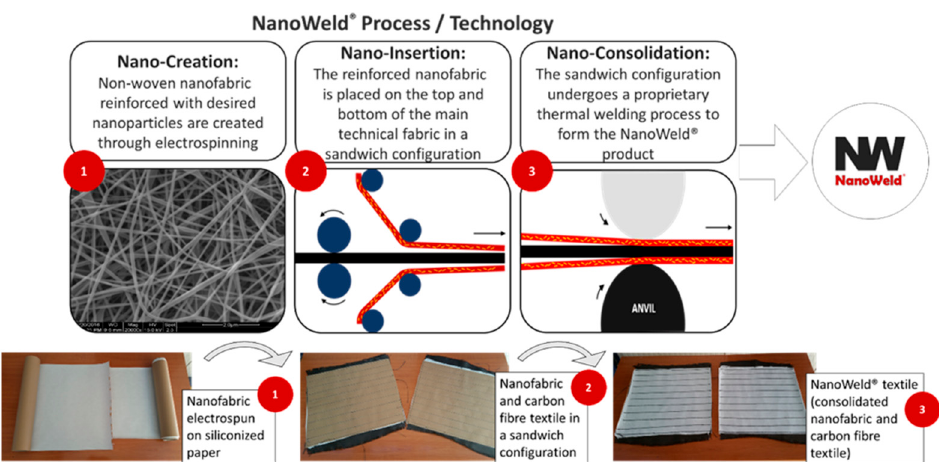
Figure 1. Schematic representation of nanofiber enhanced technical fabric main sub-processes: (1) nano-creation, (2) nano-insertion, and (3) nano-consolidation.